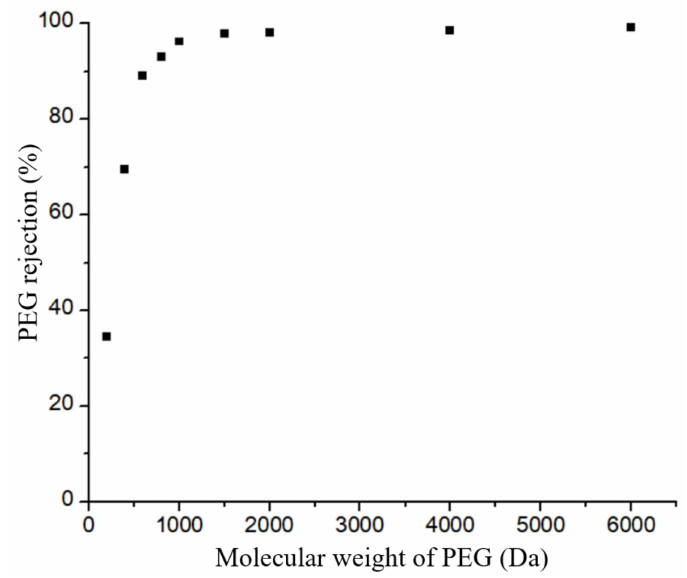
Figure 11. PEG rejection of the TiO 2 /GO-Al 2 O 3 HF NF membrane.